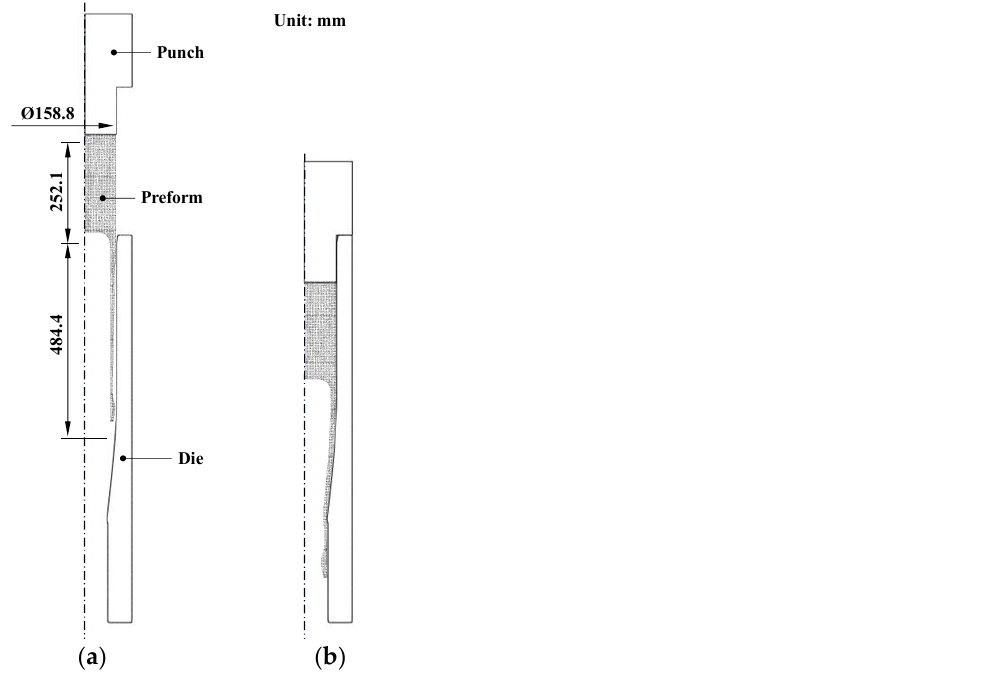
Figure 1. The cold shell nosing process: ( a ) initial configuration and ( b ) final configuration.